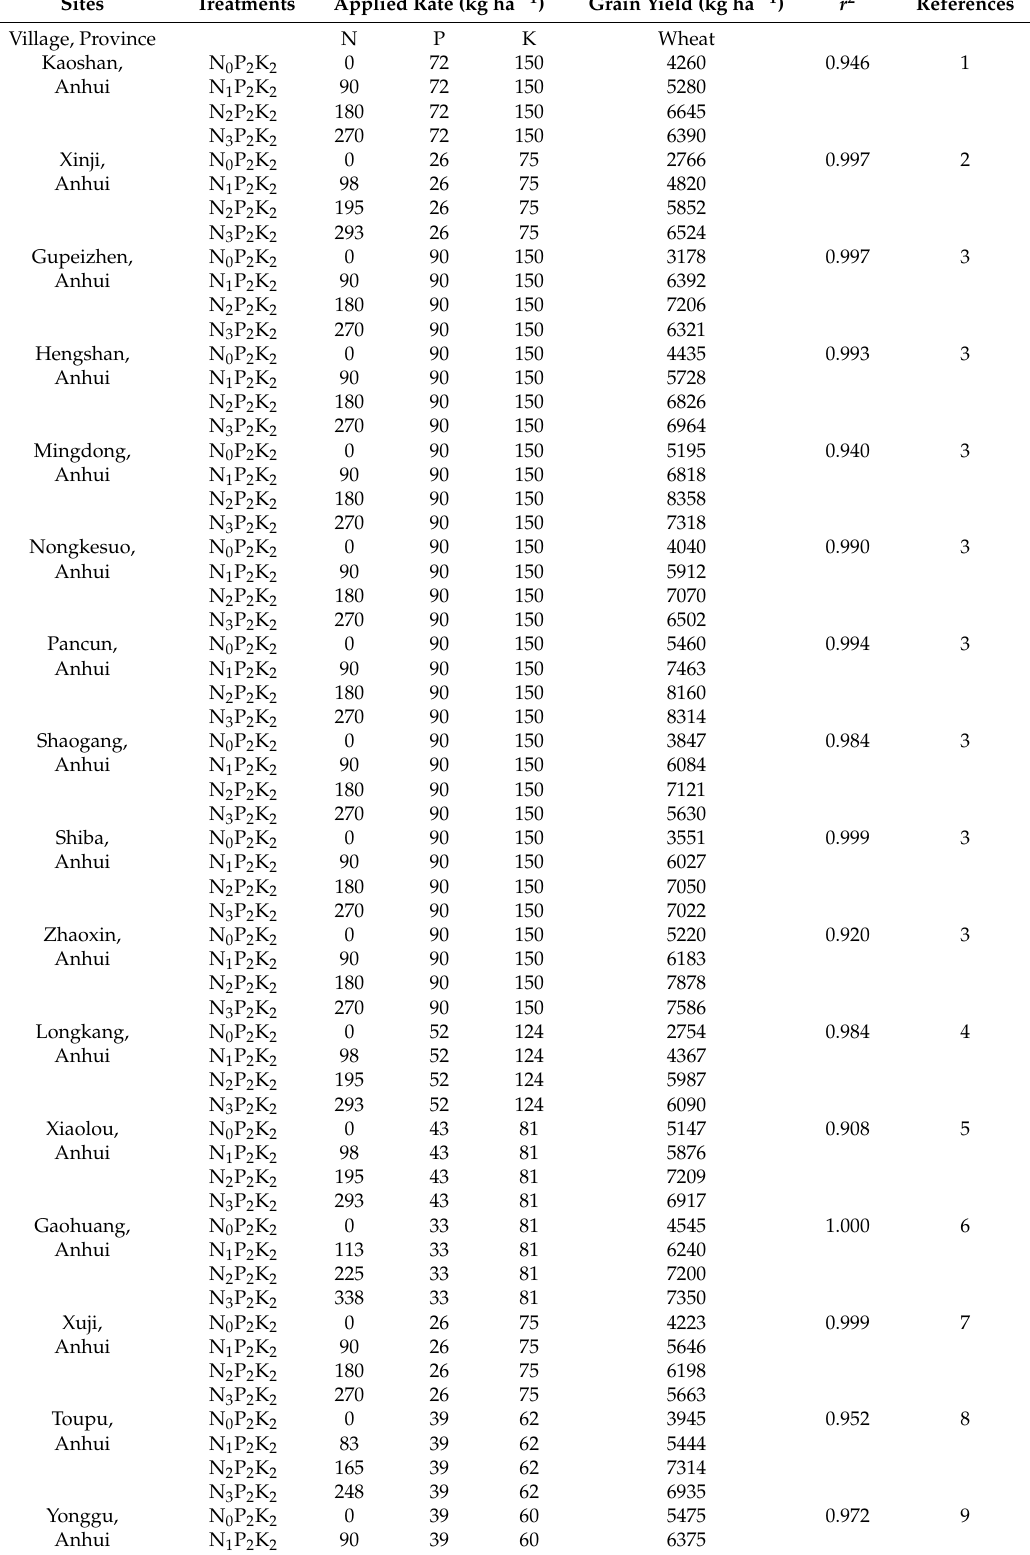
Table A1. 3414 data quoted from CSTJ (China Science and Technology Journal